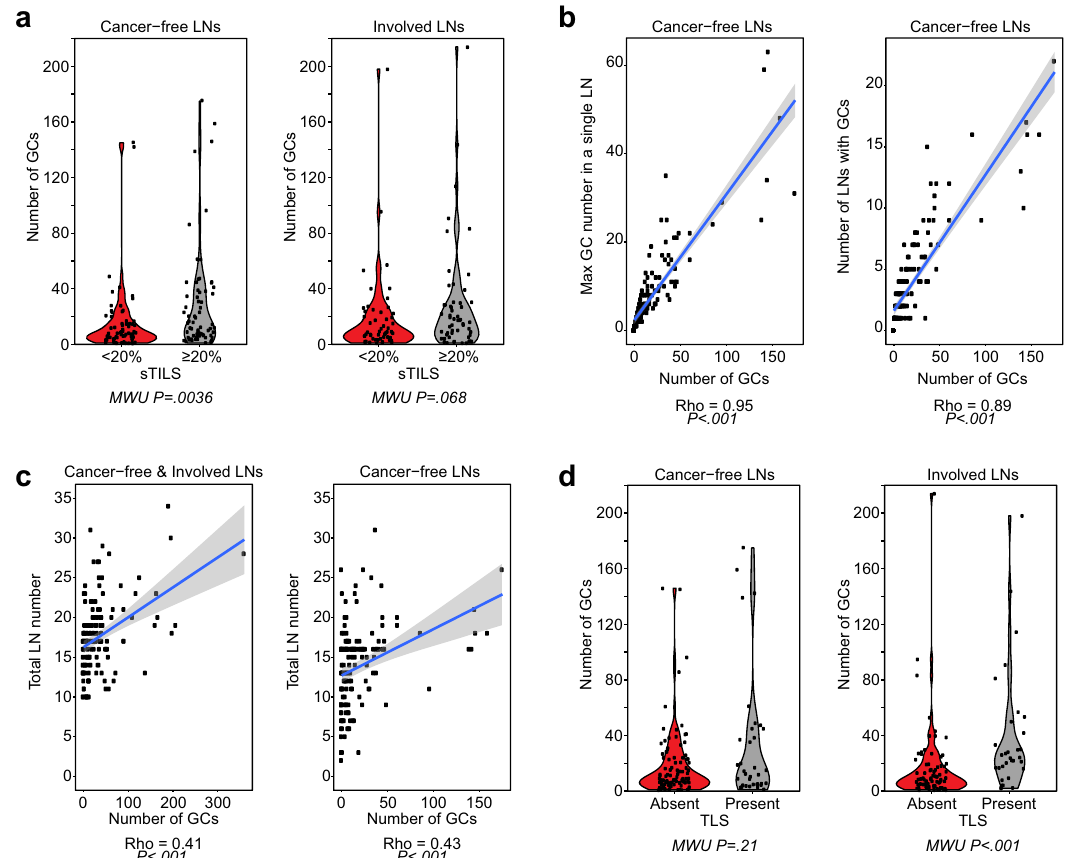
Fig. 2 Association between germinal center formation in lymph nodes, stromal TILs and tertiary lymphoid structures. a Violin plots, showing the distribution of germinal centers (GCs) compared to sTILs with 20% cut-off (<20% sTILs ( n = 86) and ≥ 20% sTILs ( n = 75)) (X axis), in cancer-free LNs (left), and involved LNs (right). b Scatter plot of the number of GCs compared to the maximum number of GCs in a single LN (left side); and compared to the number of LNs which contain GCs (right side). c Scatter plots of the number of GCs in all assessed LNs (left) and all cancer-free assessed LNs (right) compared to the number of LNs. d Violin plots, showing the distribution of GCs compared to peritumoral TLS (Absent ( n = 123) and present ( n = 38)), in cancer-free LNs (left), and involved LNs (right). Mann – Whitney U tests were used to calculate P